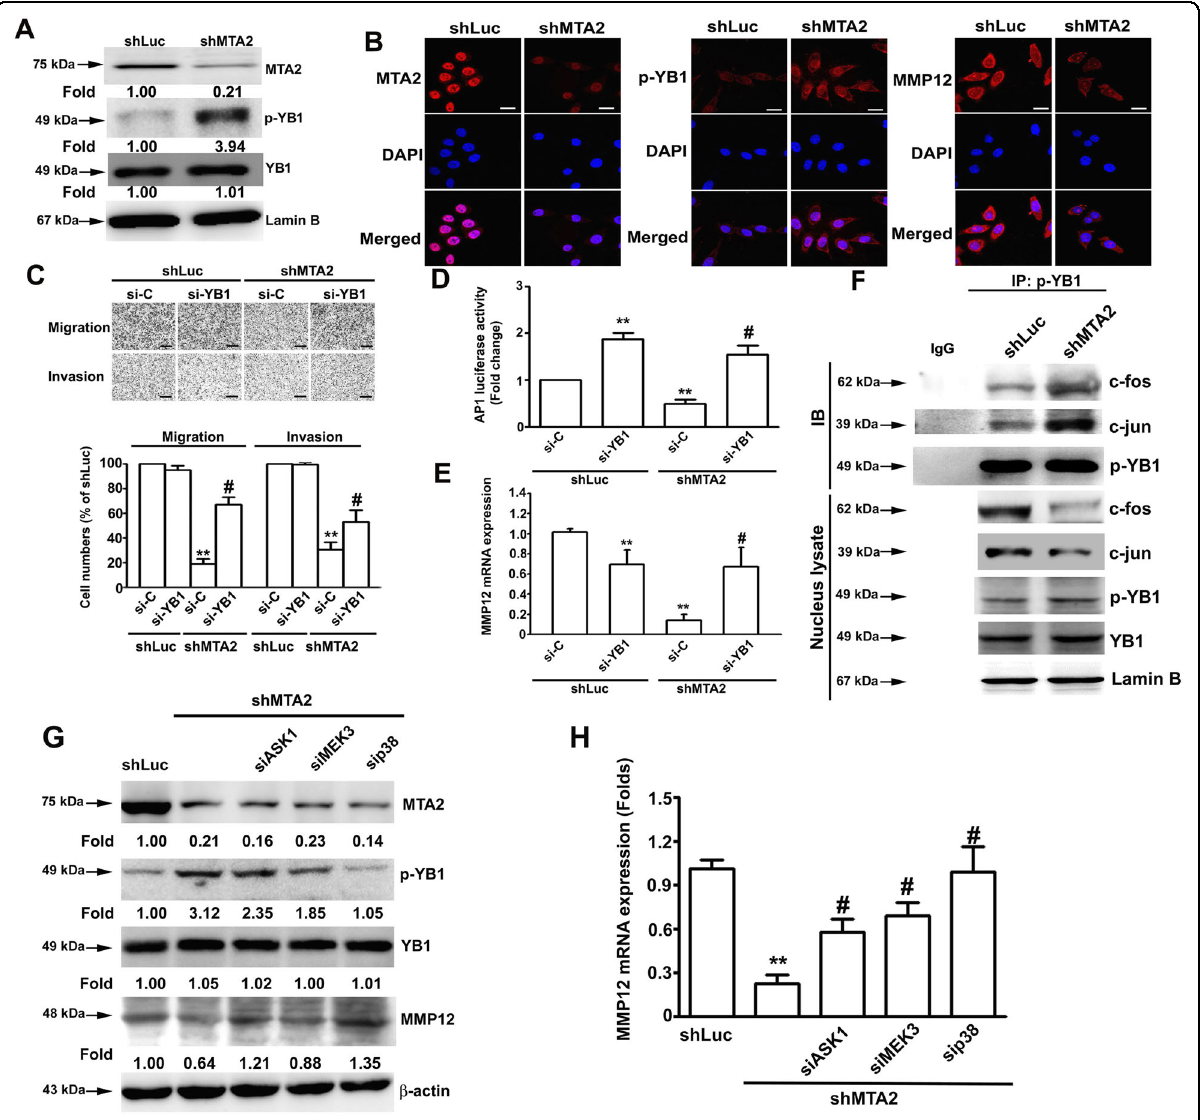
nuclear MTA2, phosphylated YB1 (p-YB1), and YB1 or ( B ) immuno fl uorescent detection of MTA2, p-YB1, and MMP12 by confocal microscopy. ( C – E) Cells were transfected with shMTA2 and siRNA against YB1 (si-YB1) and then subjected to ( C ) migration and invasion assay, ( D ) AP1 reporter assay, or ( E ) MMP12 mRNA assessment via qRT-PCR. F Cells were transfected with shMTA2 and then subjected to immunoprecipitation by using anti-p-YB1 antibody and immunodetection of the indicated poteins. ( G , H) Cells were transfected with shMTA2 combined with siRNA against ASK1 (si-ASK1), MEK3 (si-MEK3), or p38 (si-p38) and then subjected to ( G ) immunodetection of the indicated proteins or ( H ) MMP12 mRNA expression assessment via qRT-PCR. ** and #, P < 0.01 and P < 0.05 compared with shLuc and shMTA2 cells alone,